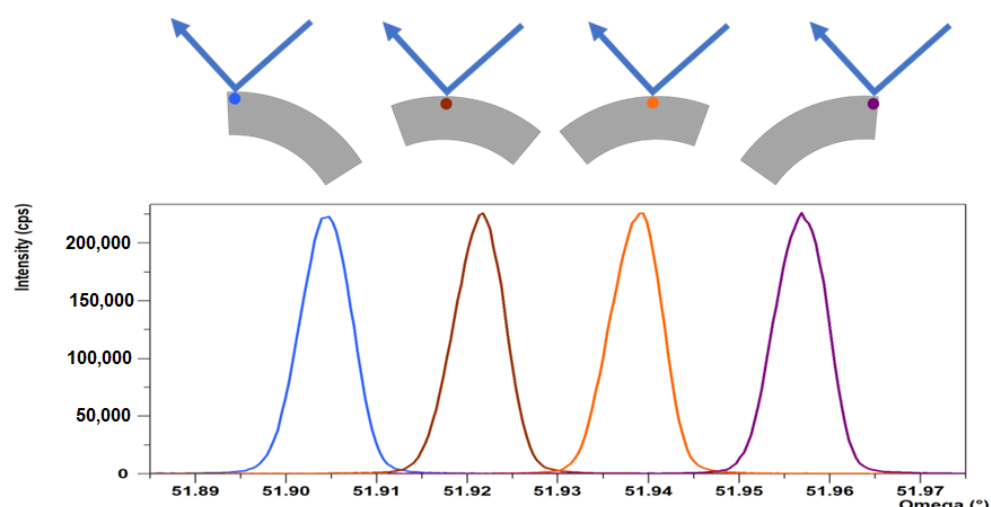
Figure 16. RCs are acquired at different positions along the curvature. As lattice planes are bent, tilt of planes changes along the curvature, thus a shift in the centroid of the rocking curves is